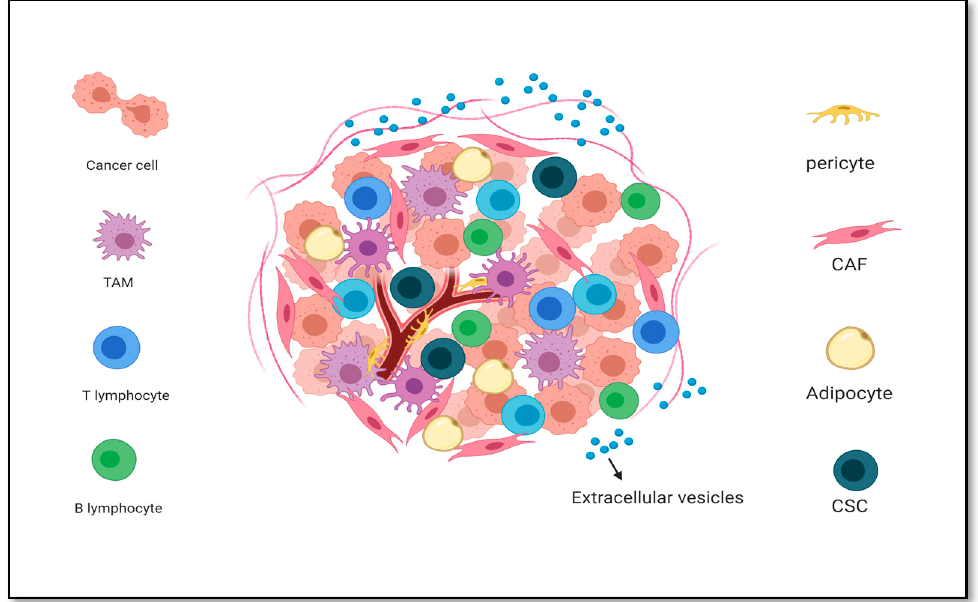
Figure 2. TME components, the different types of stromal cells, extracellular matrix (ECM), and extracellular vesicles. Created with BioRender.